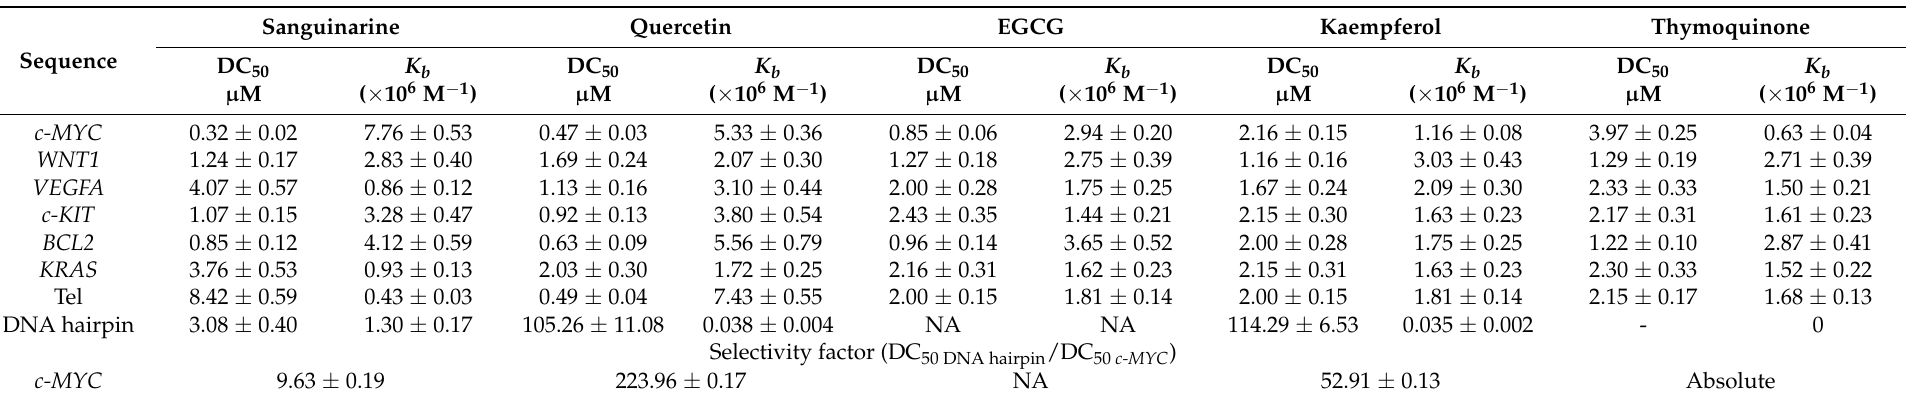
Table 2. PSM interaction with various G4s and DNA duplex analyzed by GFID